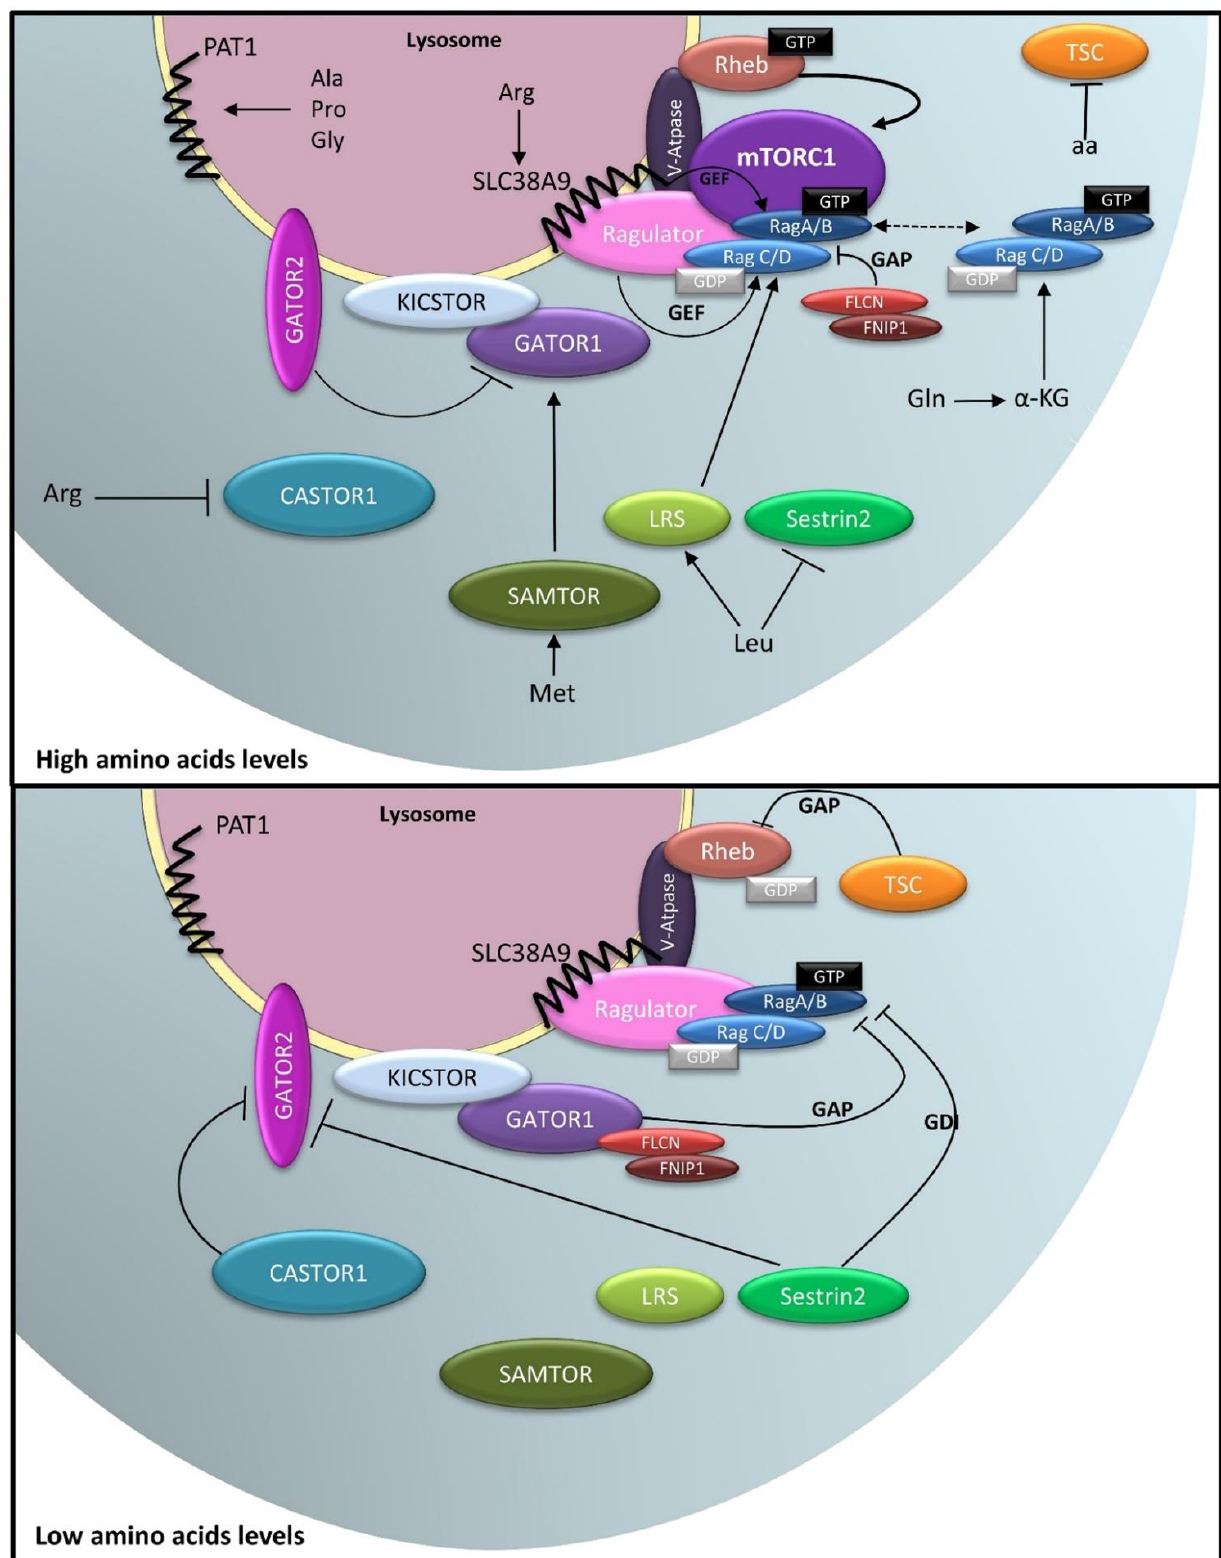
Figure 5. Role of lysosomes in amino acid sensing. Amino acids transporters, such as PAT1 and SLC38A9, regulate amino acids efflux from lysosomes and their concentration in the lysosomal lumen. Lysosomal vATPase acts as an amino acid sensor. Increased amino acid levels weaken the interaction between vATPase and Ragulator, promoting the exchange of GTP for GDP on RagC/D by